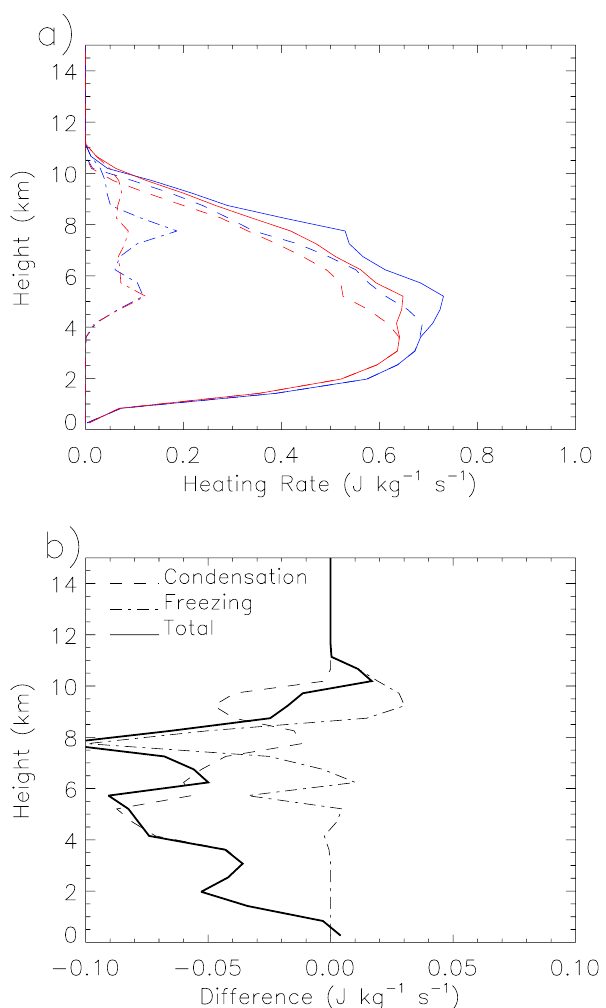
Fig. 13. As in Fig. 11, except for the configuration with latent heat- ing due to vapor deposition onto ice turned off (NODEP LH).